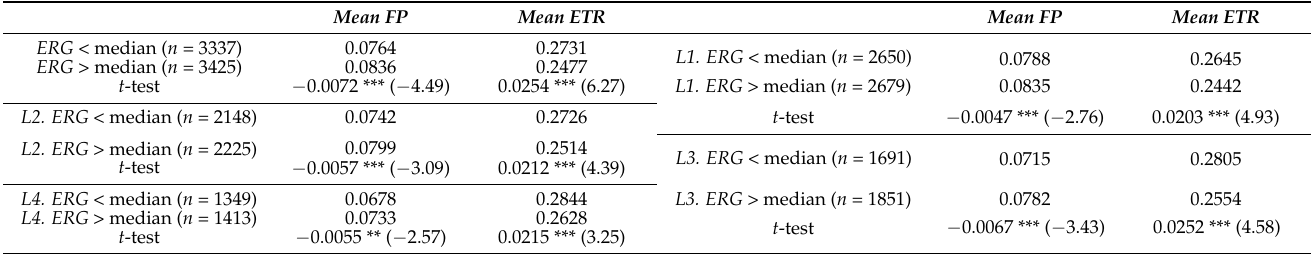
Table 4. Test of differences between corporate with different periods of